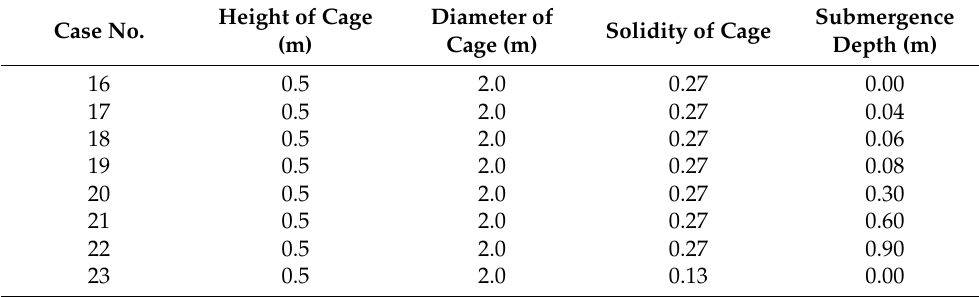
Table 5. Parameters of other influencing